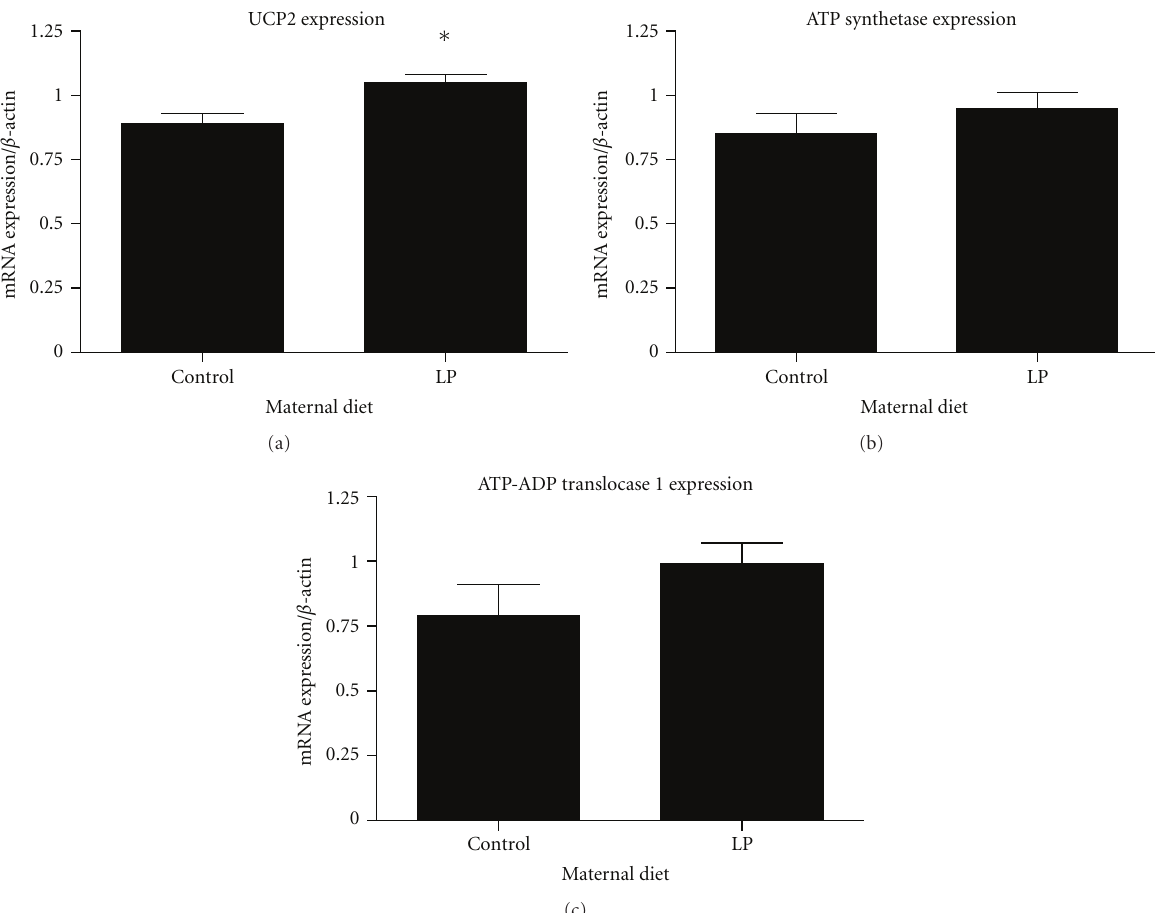
Figure 5: Gene expression of mitochondrial targets measured by RT-PCR. mRNA expression UCP2 was increased in o ff spring of protein- restricted dams. ATP Synthetase β -subunit and ATP-ADP translocase 1 were una ff ected by maternal protein restriction. Values are means ± S.E.M. n = 5 animals per group. ∗ P < 0 . 05 compared with